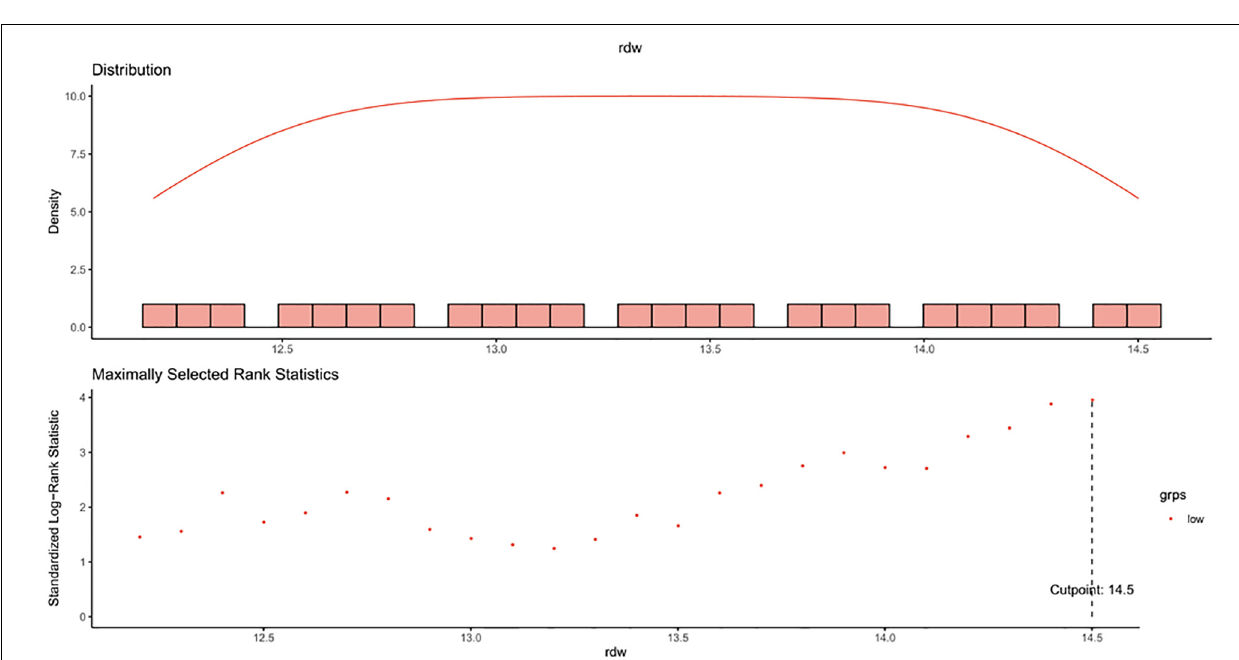
FIGURE 2 | Maximally selected log-rank statistics for cut-off point of RDW. RDW, red blood cell distribution